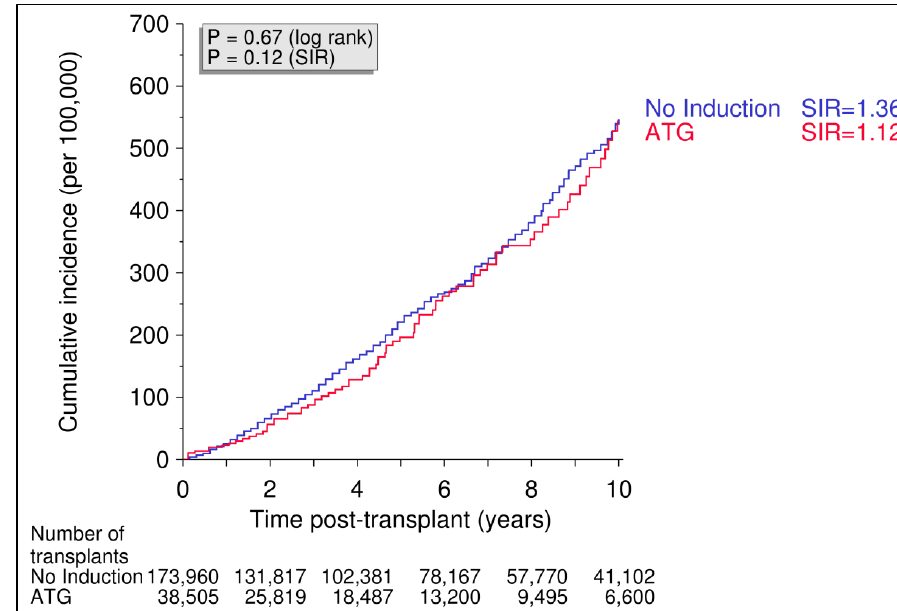
Figure 1. Cumulative incidence of colon cancer in recipients with or without induction therapy with polyclonal rabbit anti-T cell antibodies (ATG). Renal transplants performed from 1990 to 2016 were analyzed. Log rank p value for Kaplan–Meier analysis. Standardized incidence ratio (SIR) is adjusted for recipient age, gender, geographic origin, and year of tumor diagnosis.